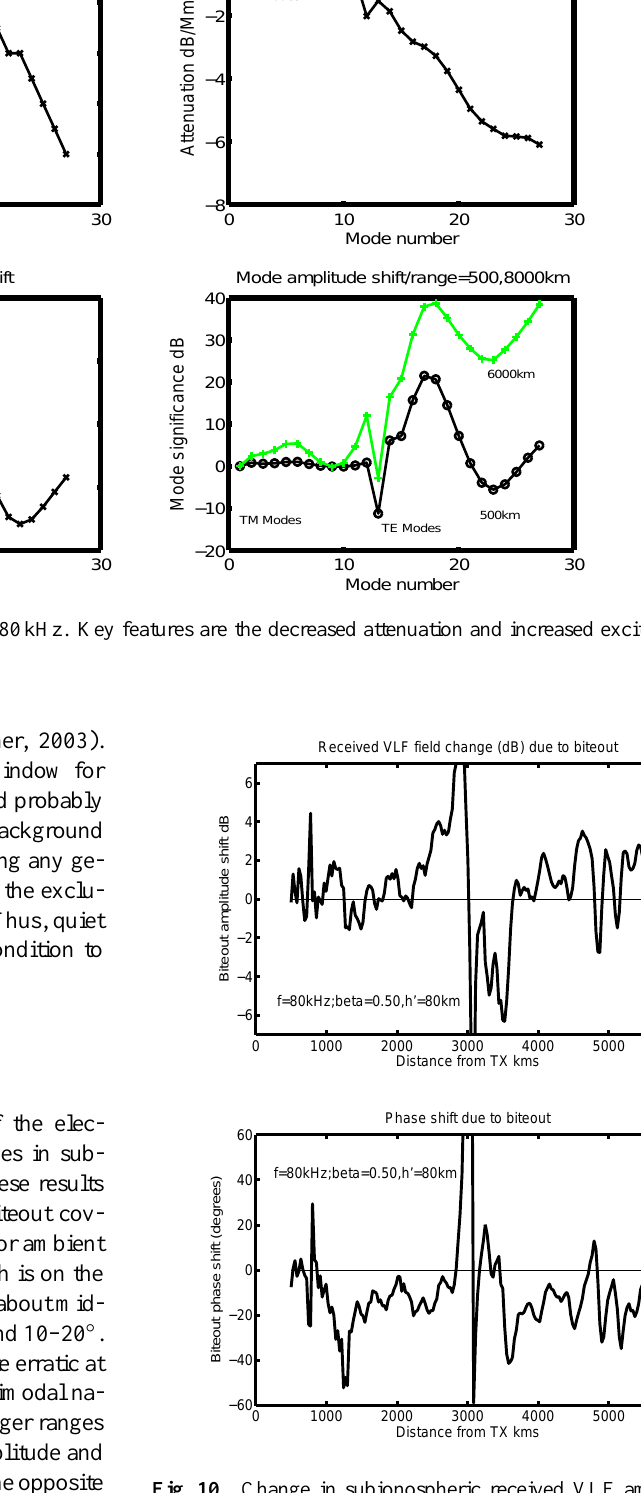
Fig. 10. Change in subionospheric received VLF amplitude and phase due to biteout, at f =80kHz. At this frequency the shift shows a complex pattern, and is mainly positive at a typical level of +2 dB. A fairly consistent pattern of negative phase shifts ∼− 20 ◦ will be